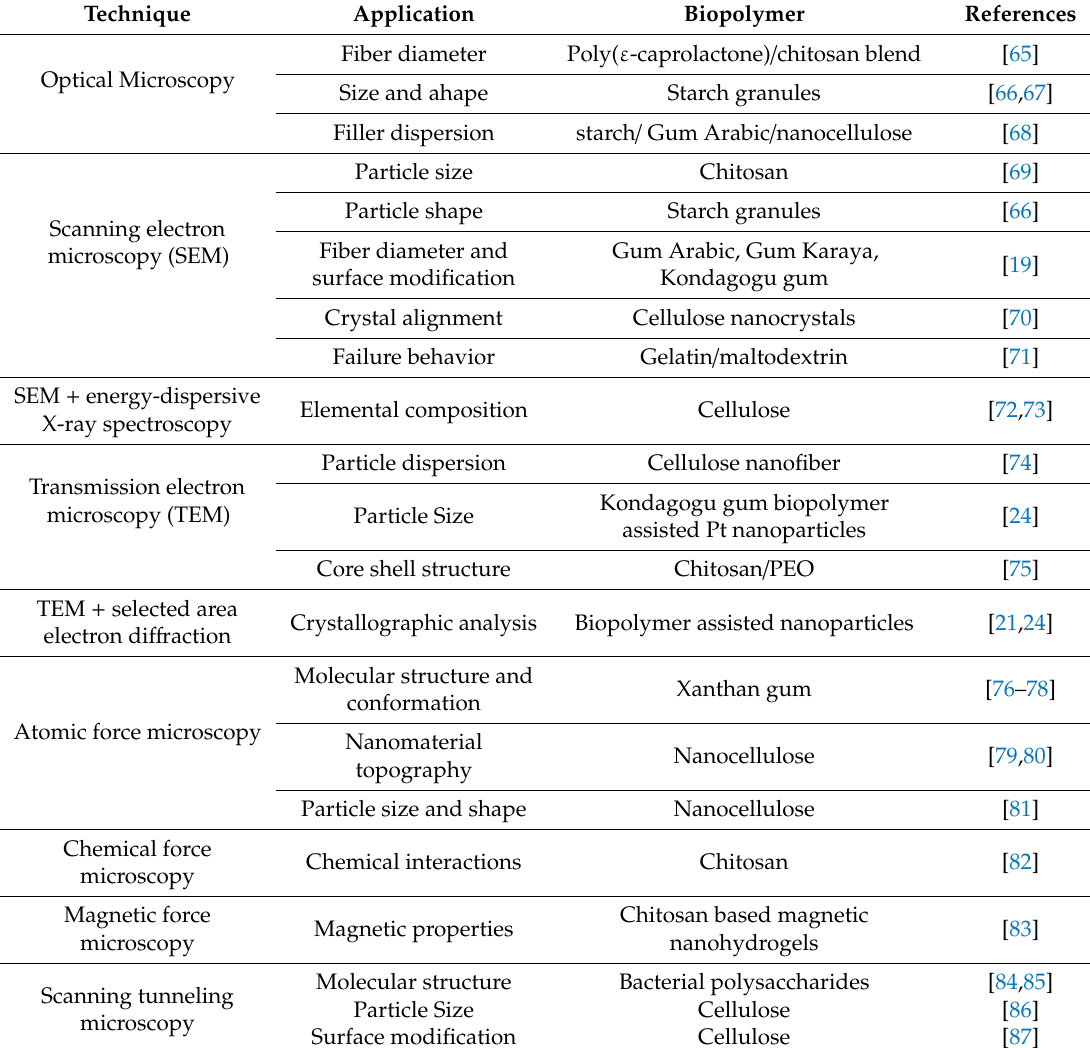
Table 1. Summary of various microscopic techniques, their applications and relevant biopolymers illustrated in the current